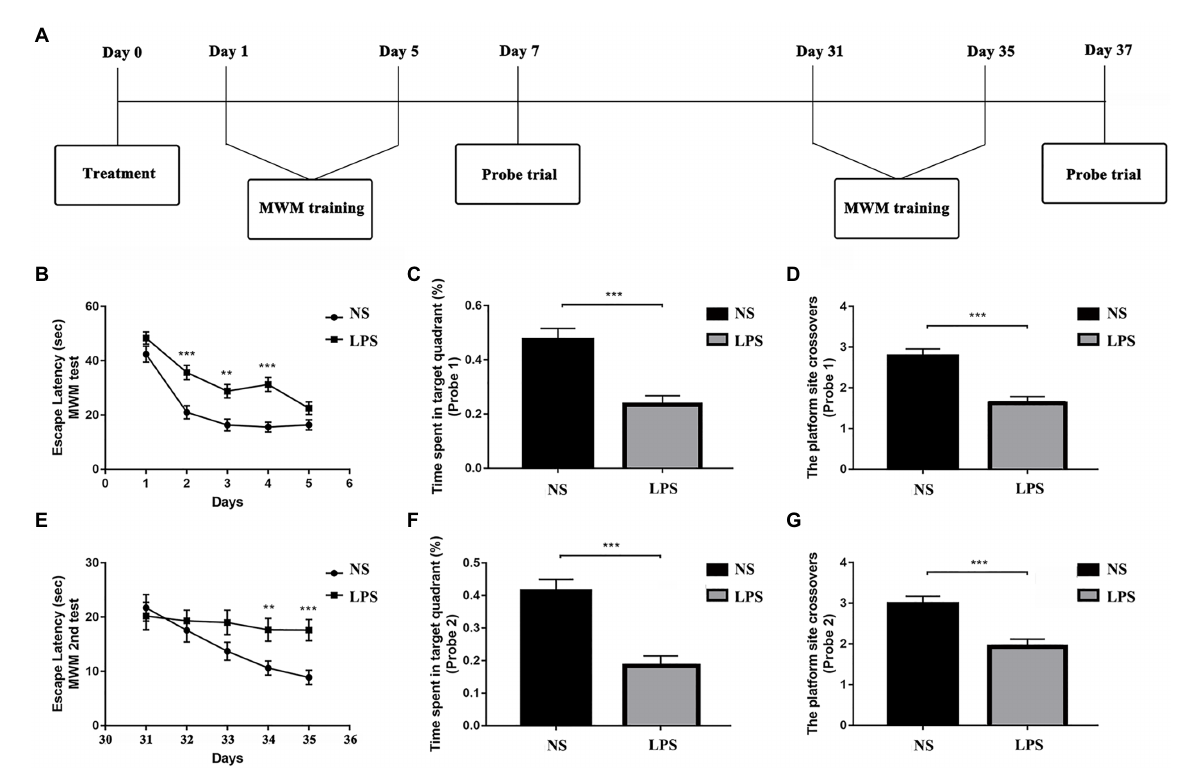
FIGURE 2 Lipopolysaccharide (LPS) exposure caused short- and long-term impaired learning and spatial working memory. (A) Morris Water Maze (MWM) test protocol. (B) Rats with LPS exposure had longer escape latency compared with those in the control group from day 2 to day 4. (C,D) Rats with LPS exposure spent shorter time in the target quadrant and performed fewer platform site crossovers compared with those in the control group. (E) Rats with LPS exposure had longer escape latency compared with those in the control group from day 34 to day 35. (F,G) Rats with LPS exposure spent shorter time in target quadrant and performed fewer platform site crossovers compared with those in the control group. Escape latency was analyzed by two-way ANOVA for repeated measurement followed by Bonferroni post hoc analysis. Time spent in the target quadrant and number of crossovers were analyzed using two-sample t -test. Data were presented as mean ± standard error of mean (SEM). * p < 0.05, ** p < 0.01, *** p < 0.001 vs. control group.